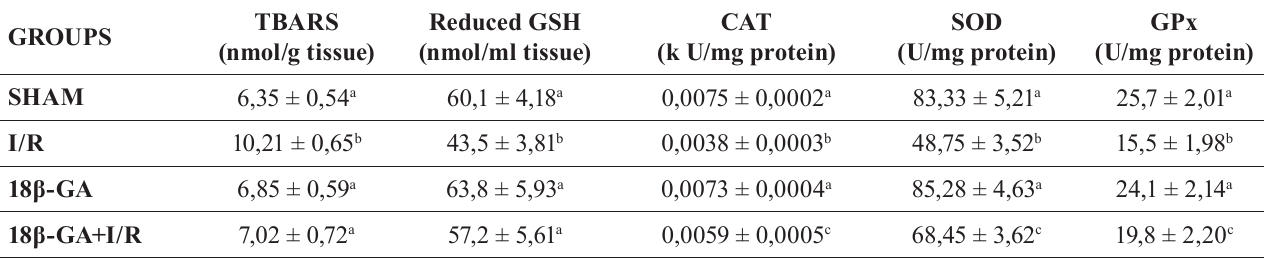
TABLE II - The levels of TBARS, GSH, CAT, GPx and SOD in heart tissue of C57BL/J6 mice. Values are presented as means ± SD. The relationships between groups and results of biochemical markers are assessed by one-way ANOVA test (post hoc Tukey test)